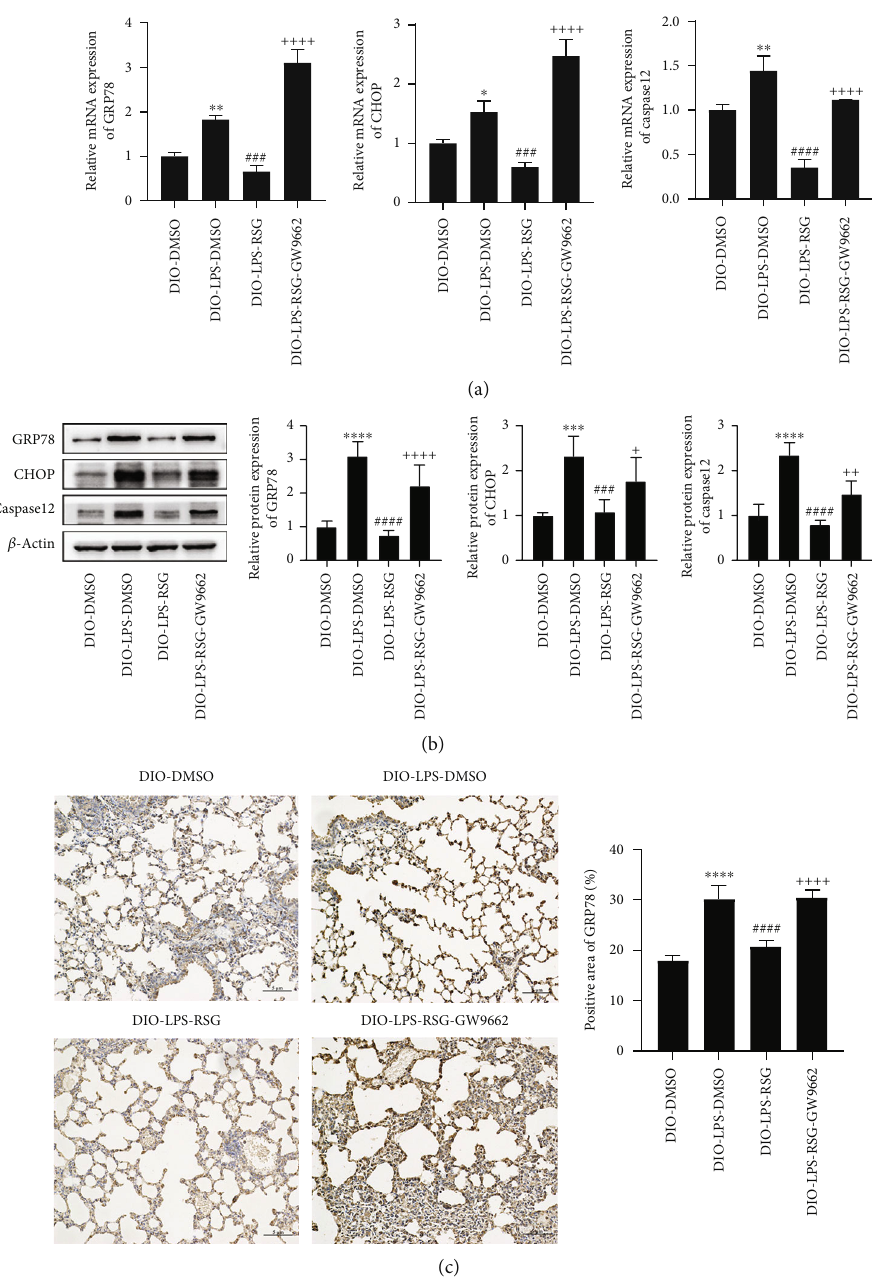
Figure 7: Activation of PPAR γ inhibited LPS-induced ER stress in lung tissue of obese mice. (a) Relative mRNA expressions of GRP78, CHOP, and Caspase12 in lung tissue. (b) Western blotting and relative protein expressions of GRP78, CHOP, and Caspase12 in lung tissue. (c) Immunohistochemical staining and positive area ratio of GRP78 in lung tissue (original magni fi cation, × 200). Data are presented as mean ± SD . ∗ p < 0 : 05 , ∗∗ p < 0 : 01 , ∗∗∗ p < 0 : 001 , ∗∗∗∗ p < 0 : 0001 vs. DIO-DMSO, ### p < 0 : 001 , #### p < 0 : 0001 vs. DIO-LPS- DMSO, + p < 0 : 05 , ++ p < 0 : 01 , ++++ p < 0 : 0001 vs.